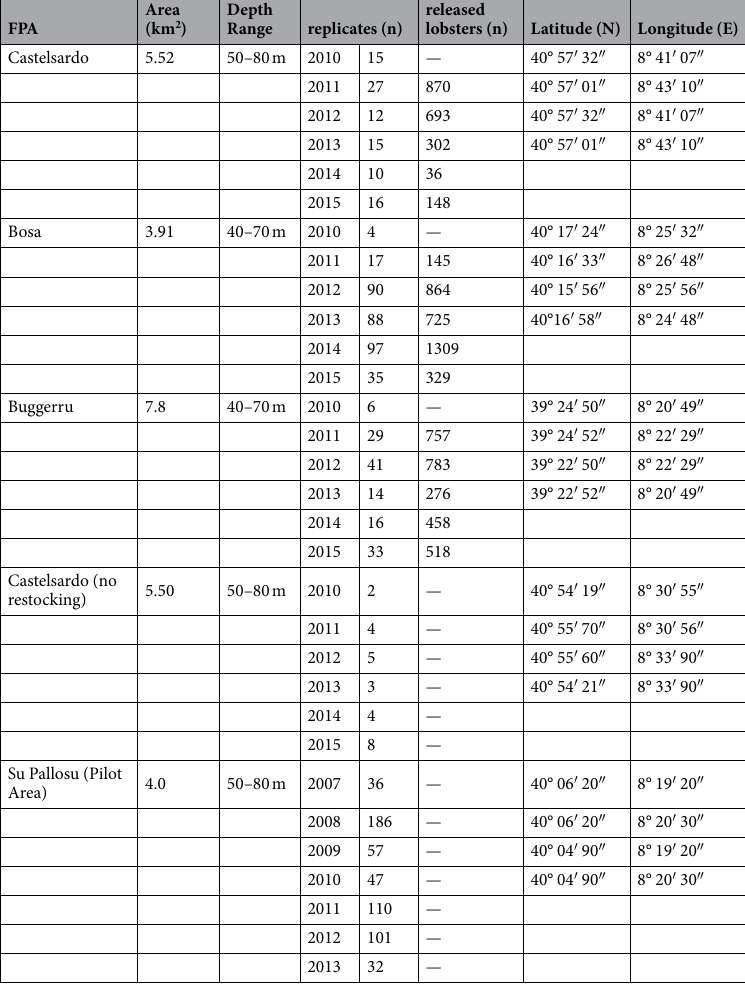
Table 1. Area, depth range and geographical coordinates of the three FPAs object of the study, plus the pilot area of Su Pallosu and the Castelsardo FPA where restocking was not performed. Reported are also the number of surveys conducted inside and outside each FPA in the five sampling years. Surveys were conducted during fishing season lasting from April 1 st to August 30 th . With respect to the FPA of Su Pallosu, we report data from 2006 to 2013, while details regarding restocking performed in the first 5 years ca be found in Follesa et al . 29